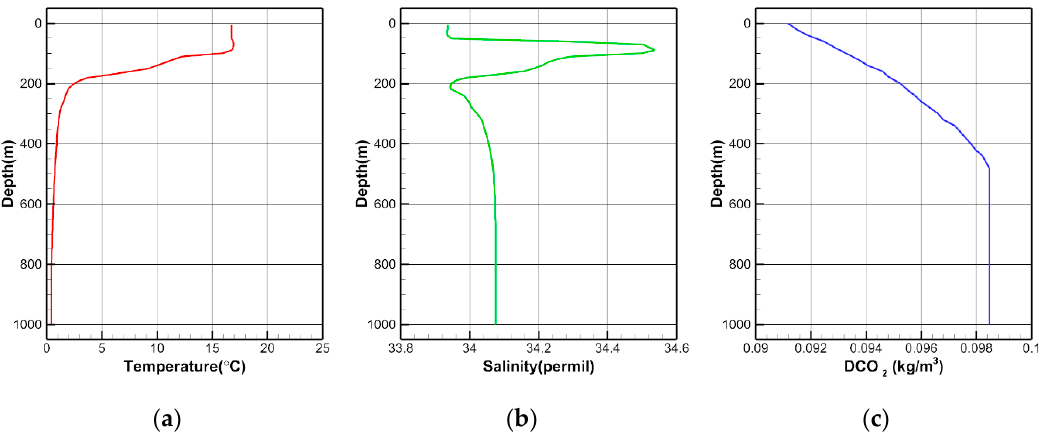
Figure 3. Initial conditions of ( a ) temperature, ( b ) salinity, and ( c ) DCO 2 .